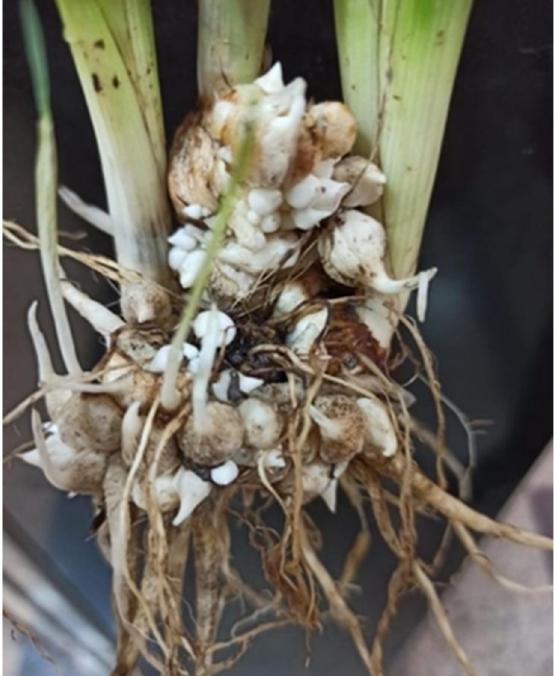
Figure 1. The reproductive phase of ‘White Prosperity’ gladiolus treated with BA at 100 ppm + removal of the apical bud. From top to bottom: base of three shoots, new corms, cormels, single leaf cormel, contractile roots, and fibrous roots.